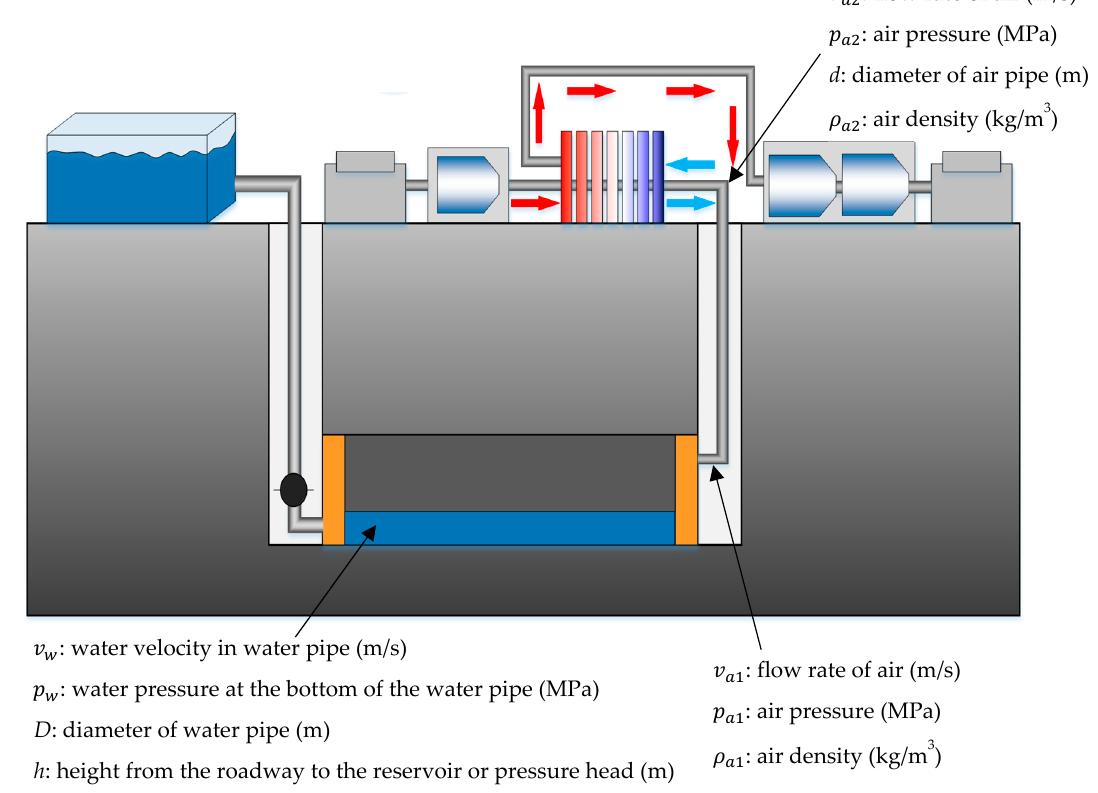
Figure 4. Variables of the storage part of the CAES system.